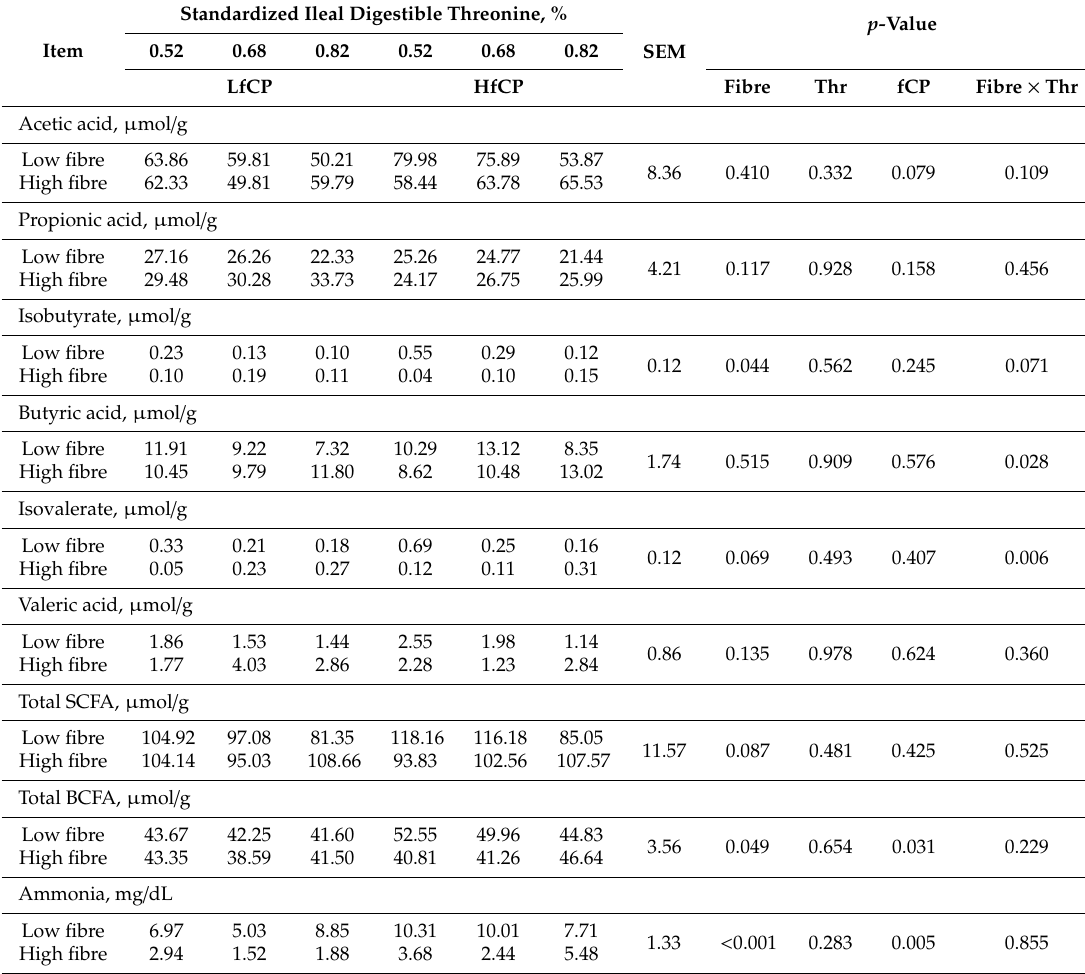
Table 3. Short-chain (SCFA), branched-chain (BCFA) fatty acid and ammonia concentration in the cecal digesta 1,2 .